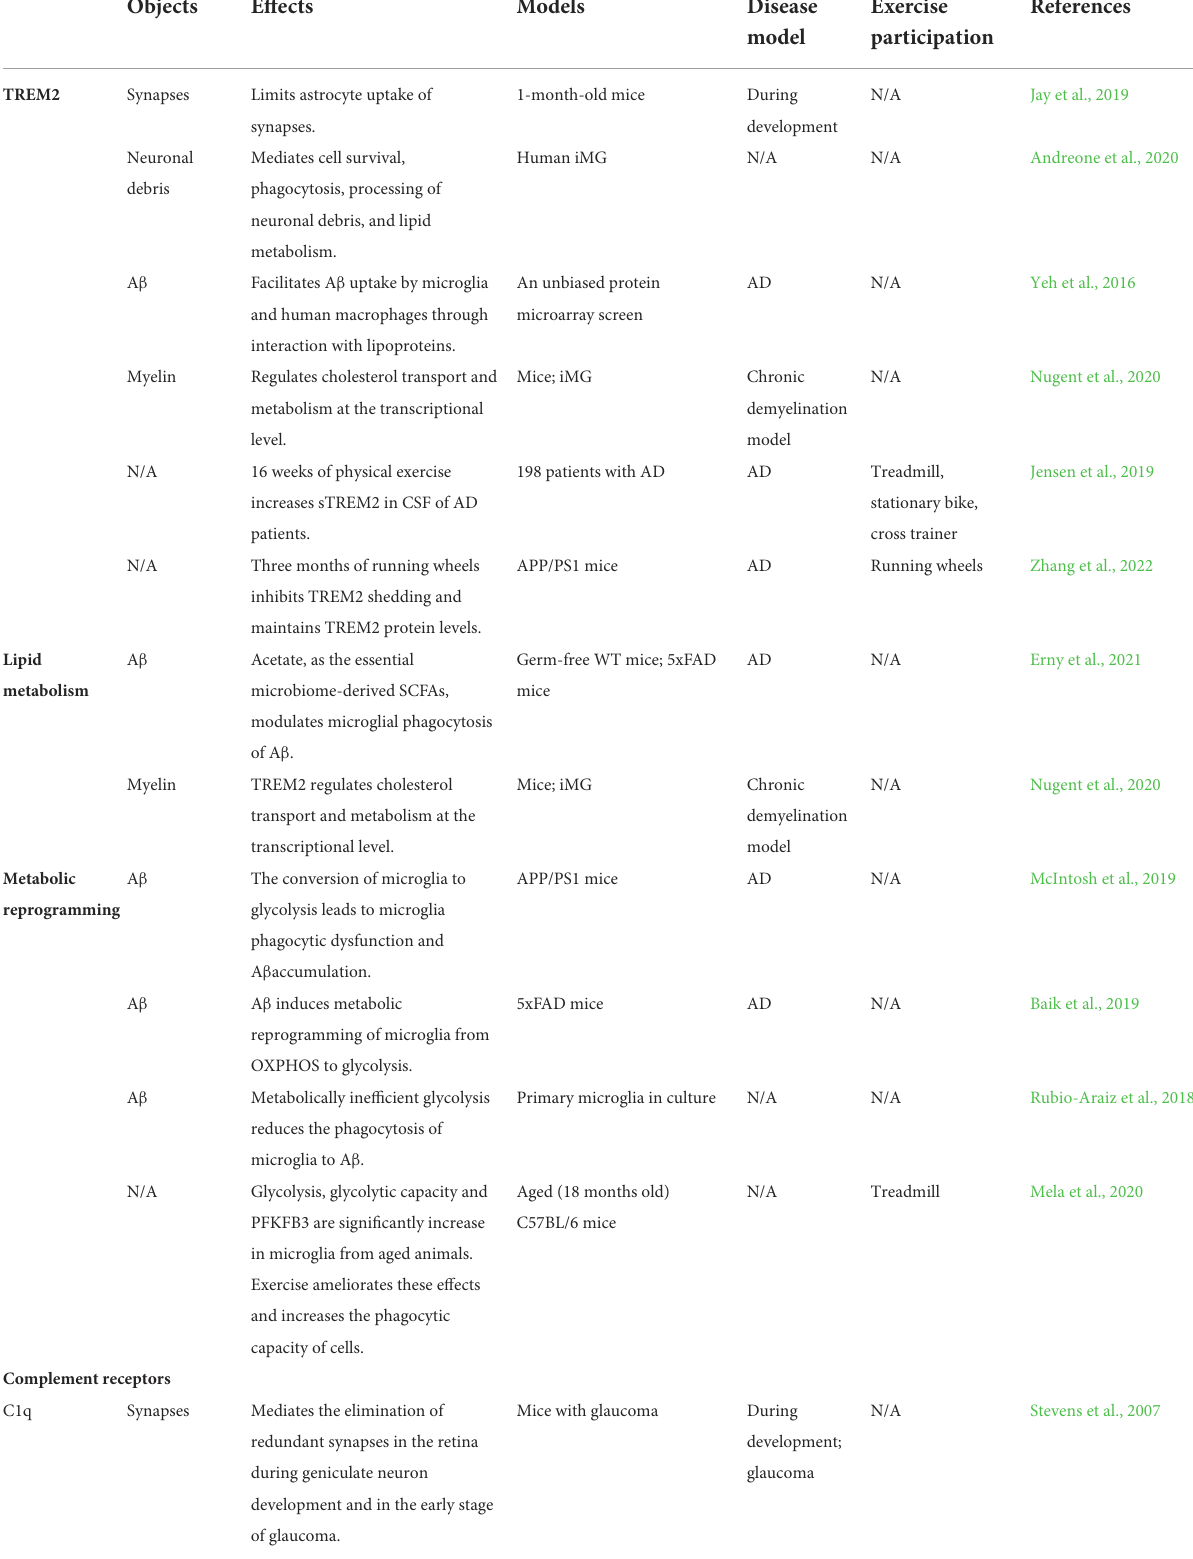
TABLE 1 Regulation mechanism and exercise participation of microglia phagocytosis in different disease models.